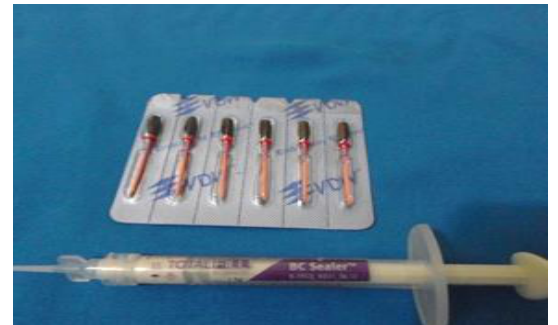
Figure 2: GuttaFusion® gutta-percha size #